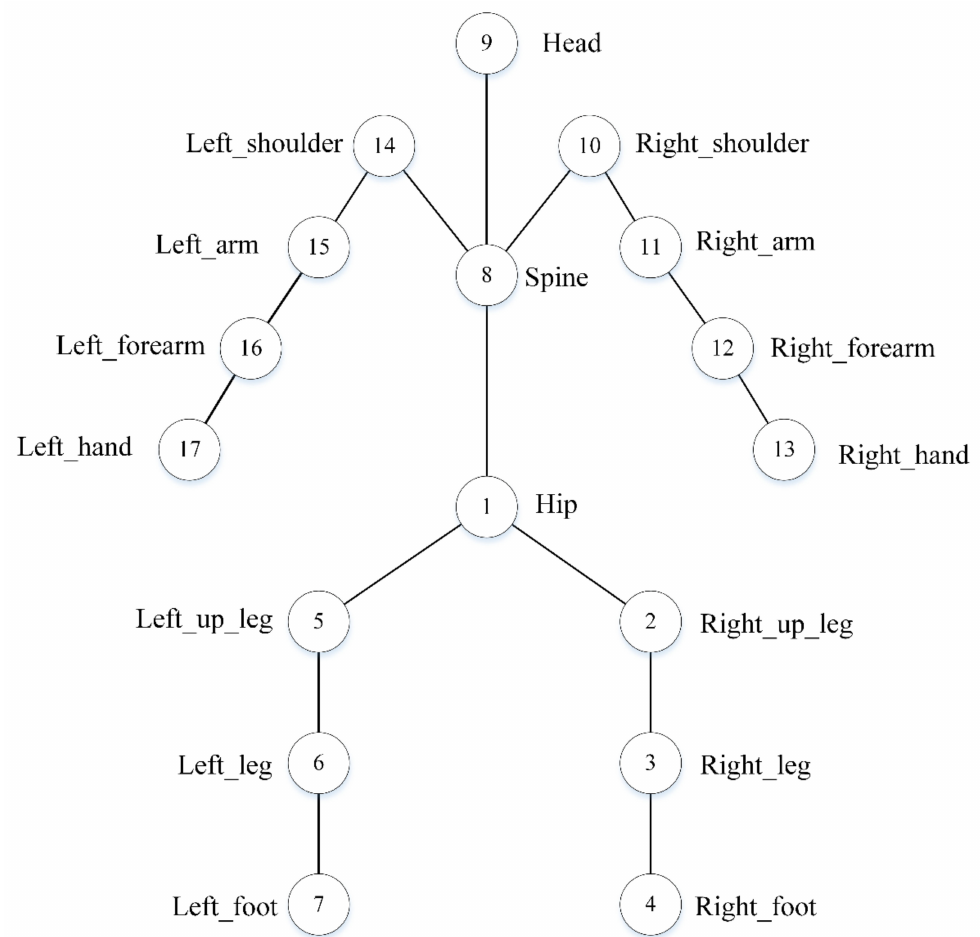
Figure 3. The skeleton model of BVH file for Perception Neuron